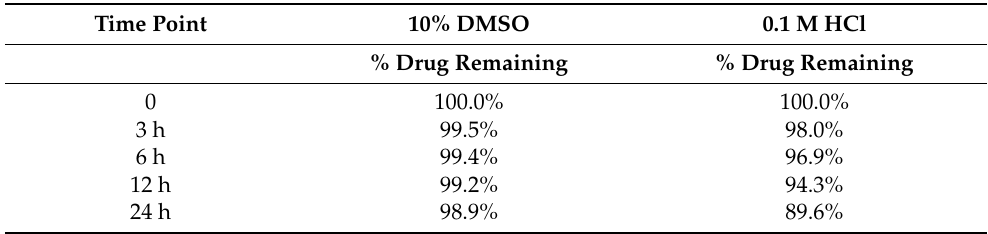
Table 2. Comparison of ceftobiprole stability in 10% DMSO and 0.1 M HCl solution. The value of 100% refers to the initial peak area of ceftobiprole without synthesis by-products (SBPs) and degradation products